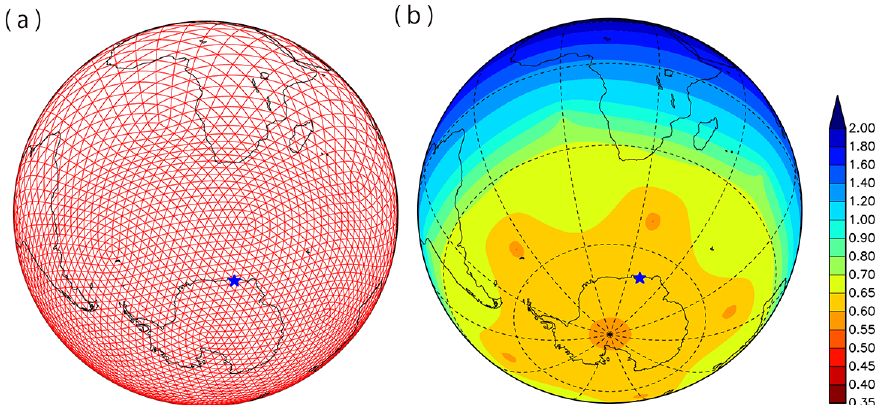
Figure 1. (a) An illustration of the stretched grid (roughened up to glevel 3). (b) A horizontal map of a normalized grid interval defined as d/(cid:49)x , where d denotes grid intervals and (cid:49)x denotes the grid interval of the original icosahedral grid.